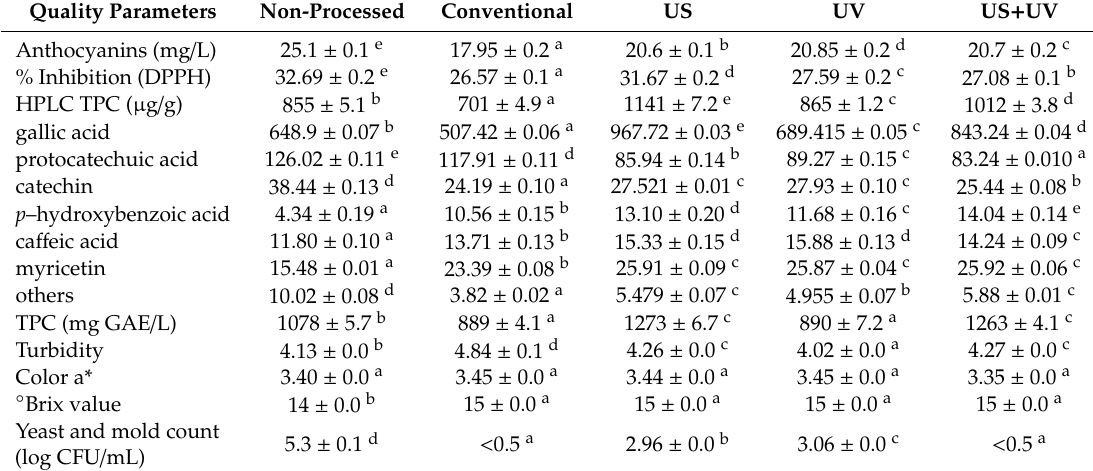
Table 7. Variation of the quality parameters of pomegranate juice in di ff erent pasteurization conditions vs